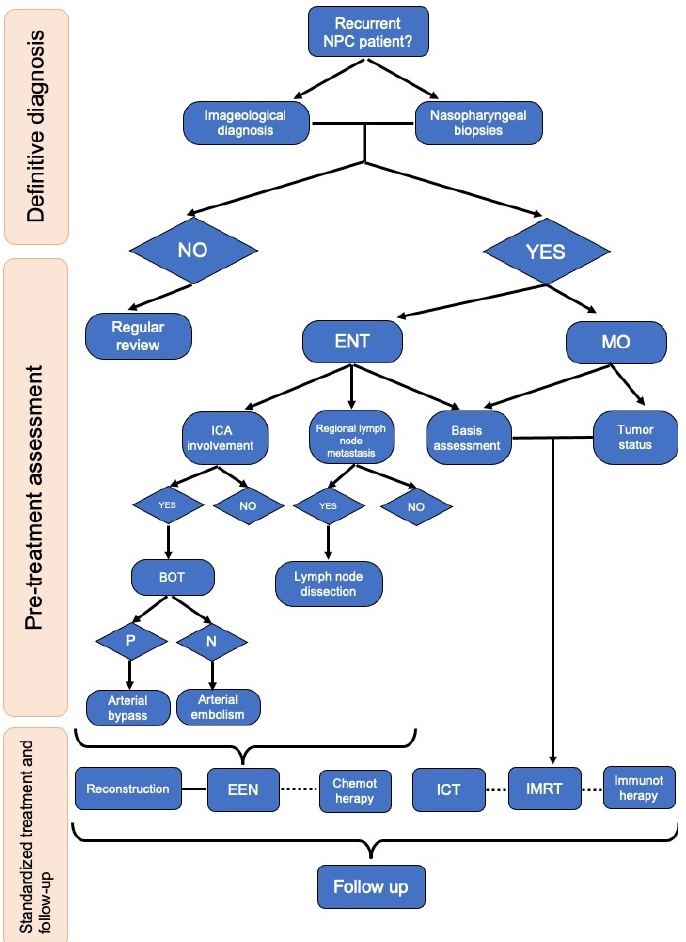
Figure 3. Flowchart for the diagnosis and treatment of recurrent NPC with post-treatment manage- ment. ENT, ear nose and throat; MO, medical oncology; ICA, internal carotid artery; BOT, balloon occlusion test; P, positive; N, negative; EEN, endoscopic endonasal nasopharyngectomy; ICT, induc- tion chemotherapy; IMRT, intensity-modulated radiation